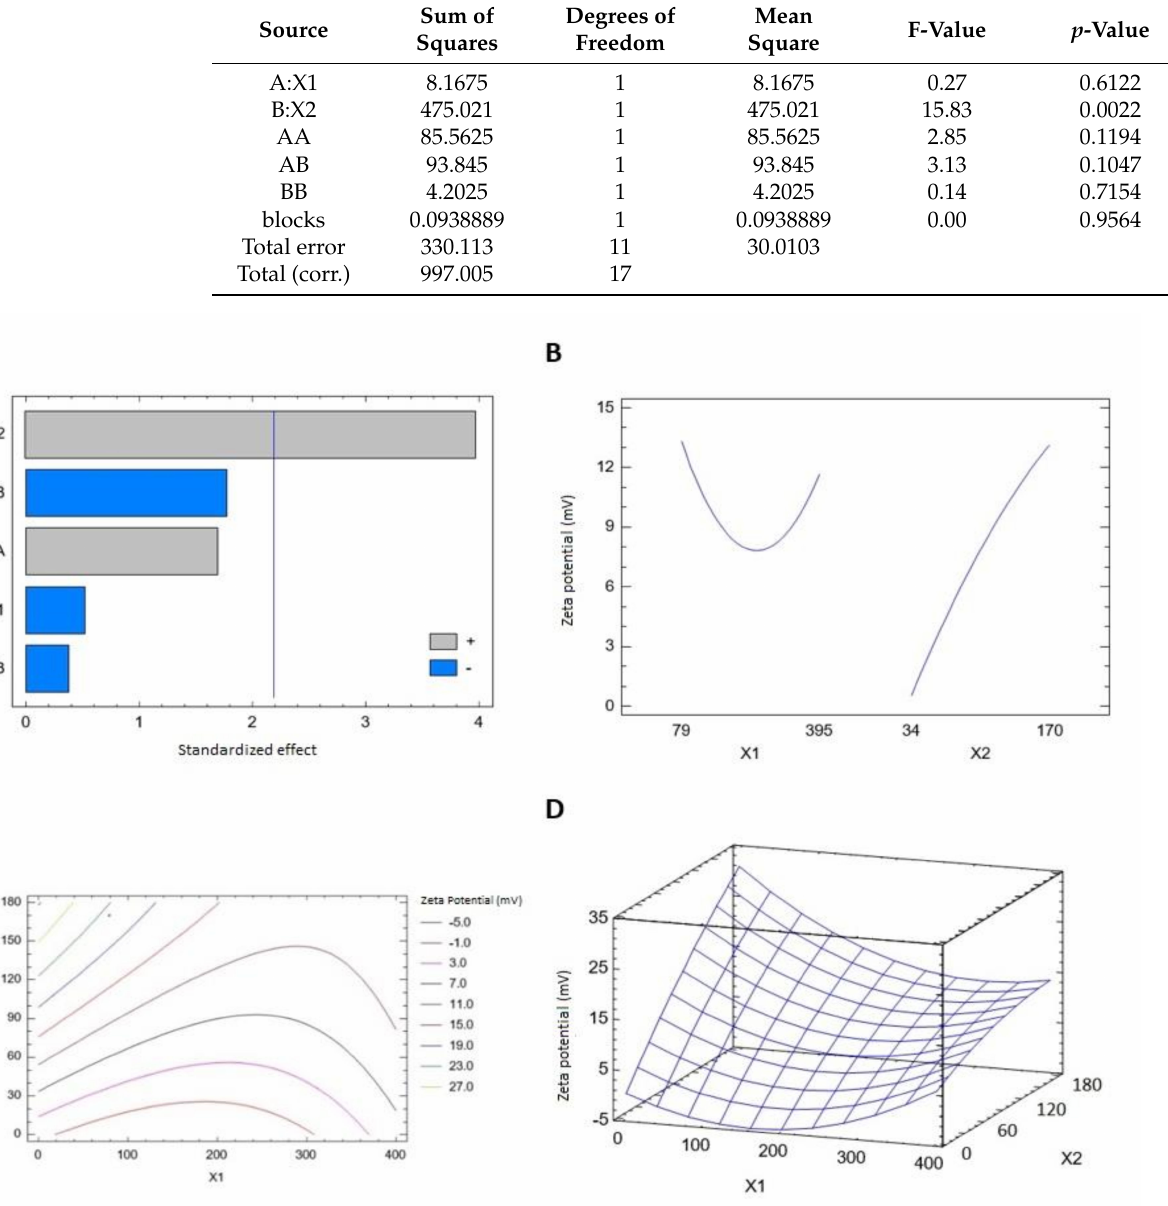
Table 5. Analysis of variance for the zeta potential of THQ–PL–SV phytosomes.